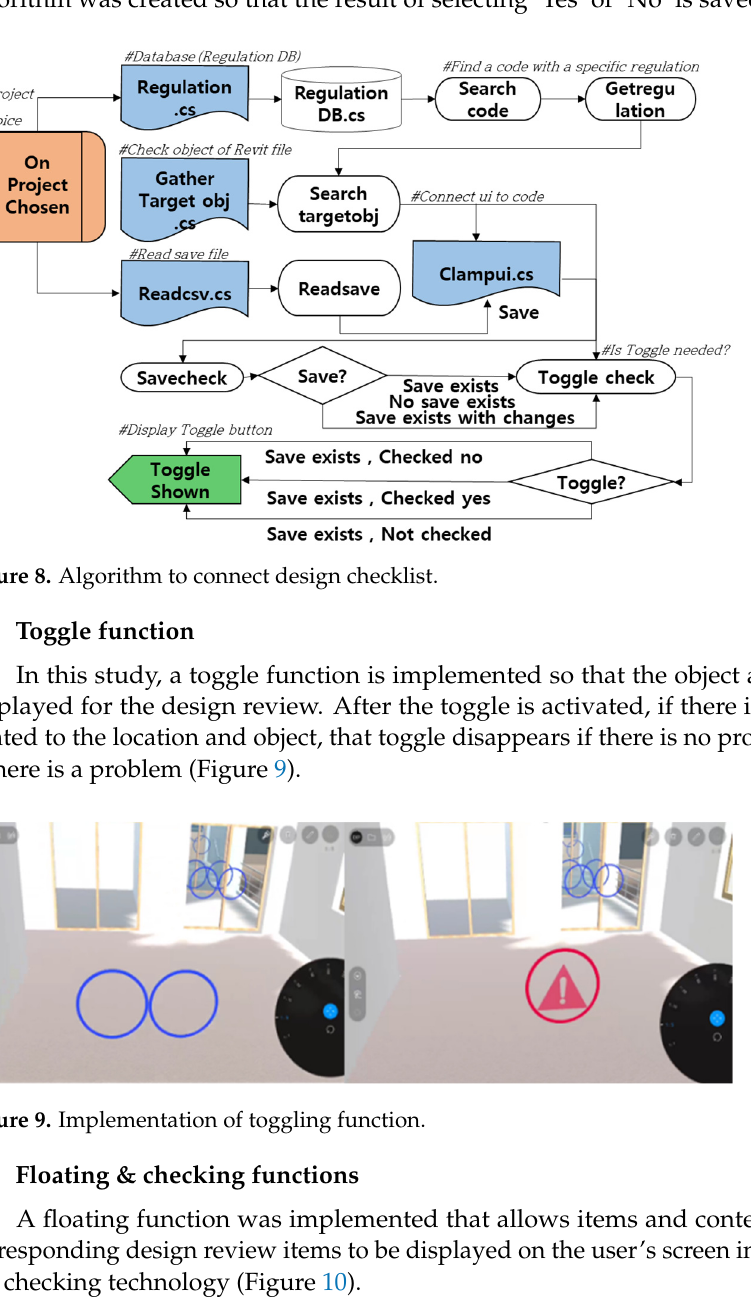
Figure 7. Meaning of Symbols for Algorithm.